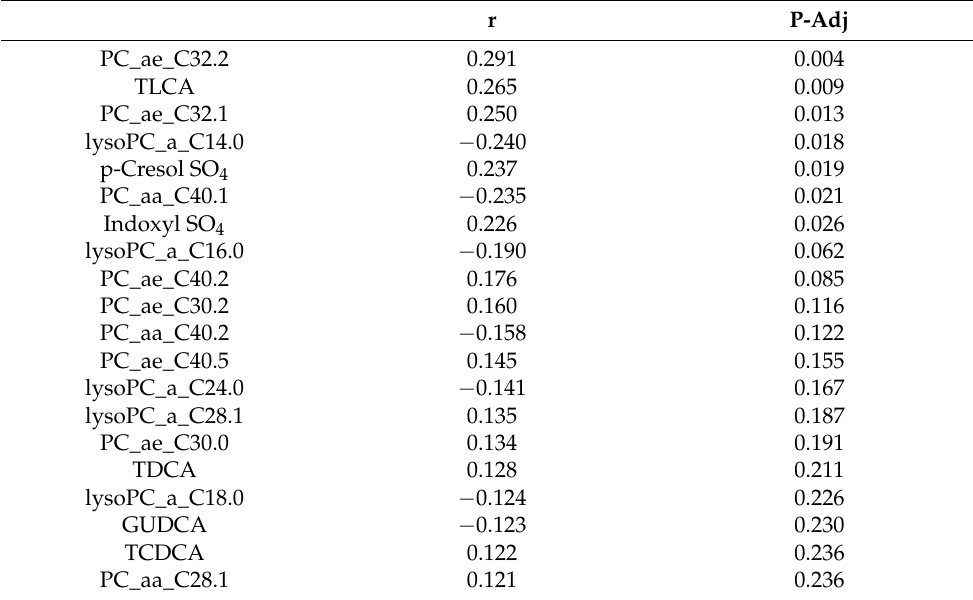
Table 5. Correlation of AUC-TMAO and AUC metabolites. The relationship between 6 h exposure to phosphatidylcholines, lysophosphatidylcholines, bile acids, and uremic toxins was correlated to exposure to